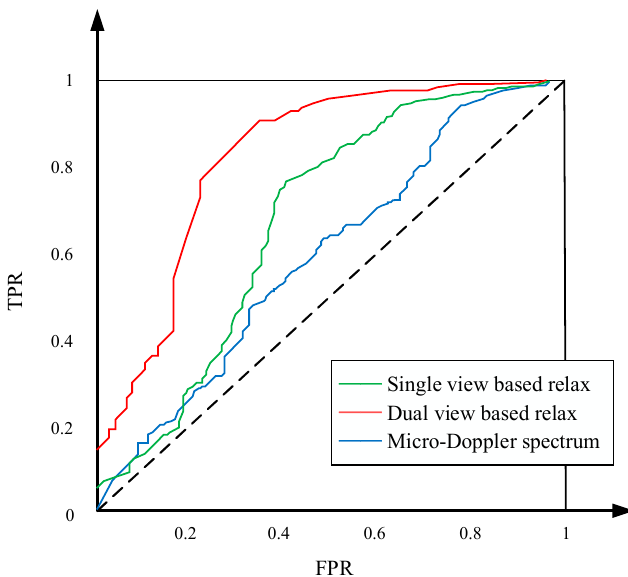
Figure 16. ROCs of three different mechanisms. Table 6. AUC obtained from three different mechanisms.